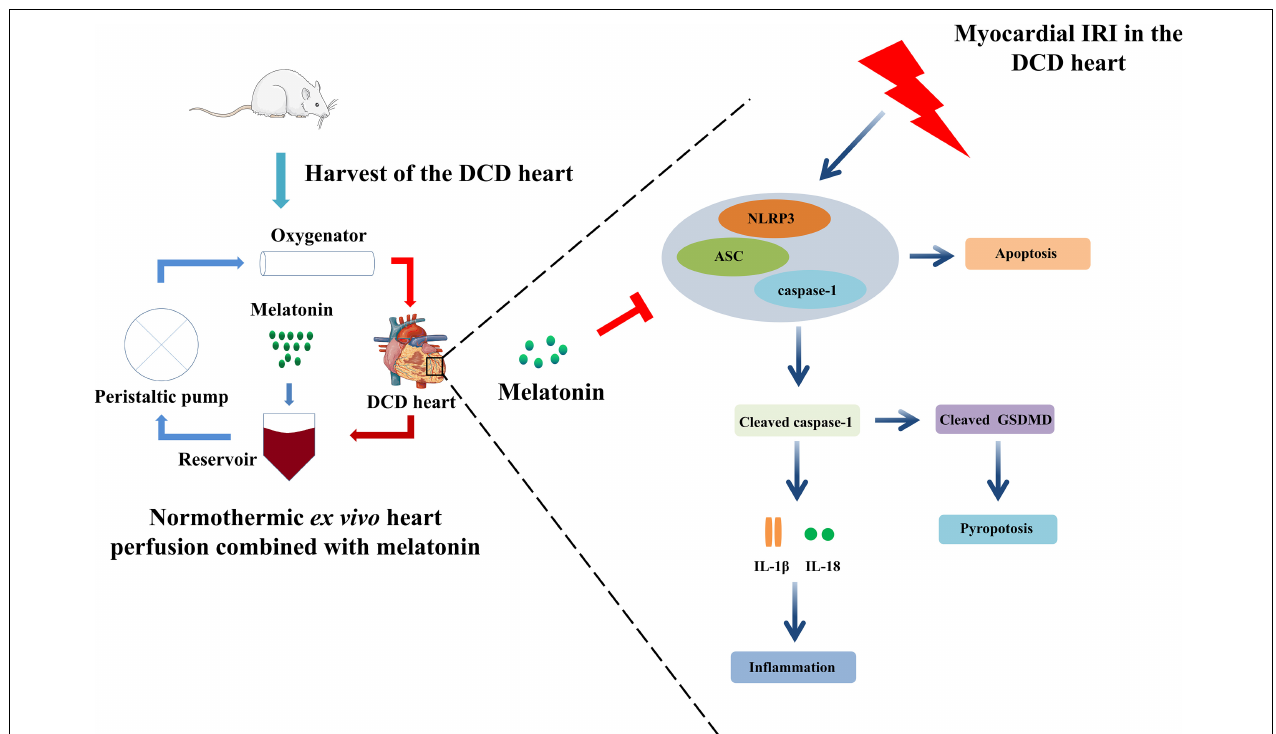
FIGURE 8 | Ex vivo heart perfusion combined with melatonin post-conditioning exerts a profound cardioprotective effect against myocardial IRI in the DCD heart, and this protection appears to be due to the inhibition of NLRP3 inflammasome-mediated pyroptosis. IRI, ischemia/reperfusion injury; DCD, donation after circulatory